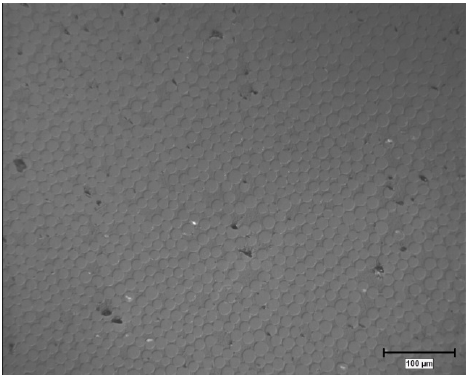
Figure 13. Microstructure image of sample A2 on its flat side surface, 200×. The ECR glass fibers in section and slightly darker epoxy resin are visible. Dark chipping of fiber fragments and less often of binder are few.